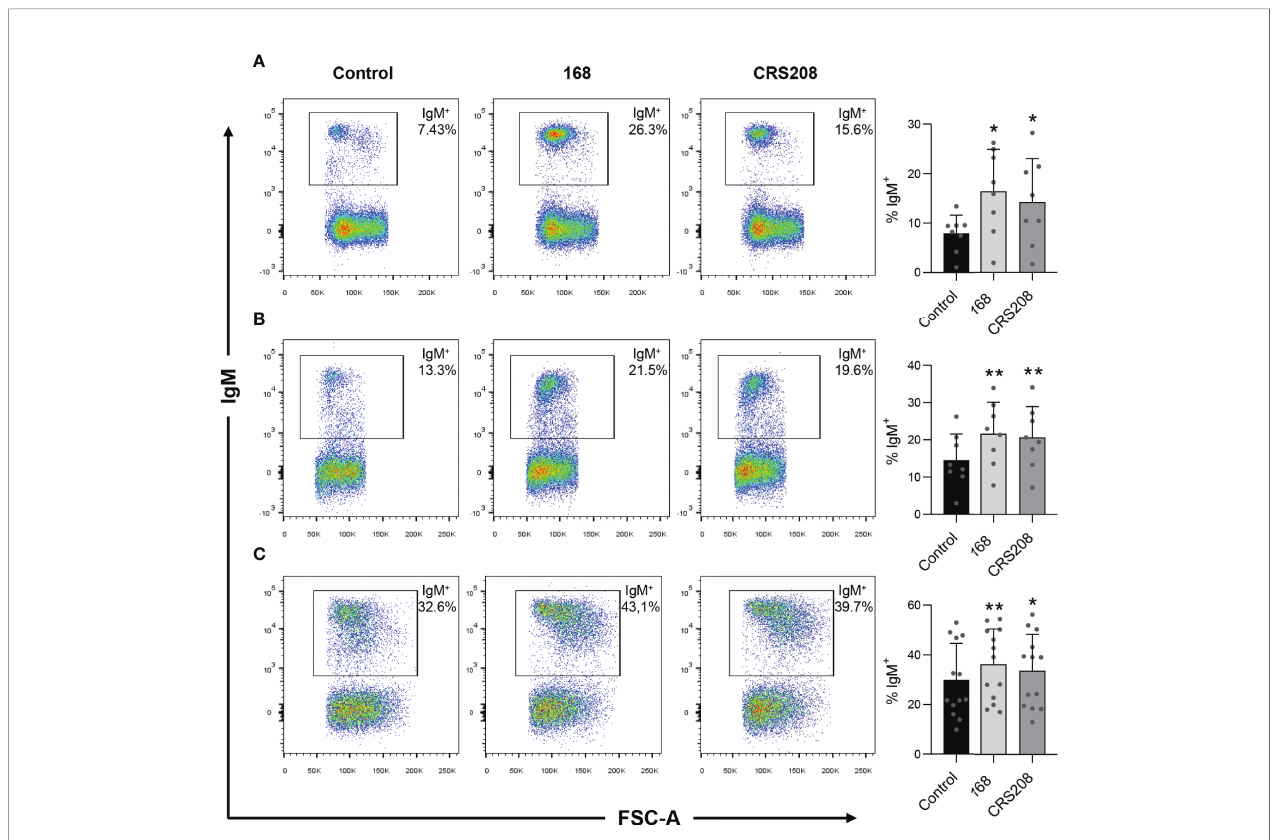
FIGURE 2 | Effect of B. subtilis 168 and CRS208 strains on the percentage of IgM + B cells. The percentage of IgM + B cells was measured via fl ow cytometry using a speci fi c anti-IgM in spleen (A) , kidney (B) and peritoneal (C) leukocyte cultures treated with 1x10 7 cfu/ml B. subtilis 168 or CRS208 strains for 48 h. Controls not treated with bacteria were also included. Representative dot plots are included along with graphs showing the percentage of live IgM + B cells in the lymphocyte gate (mean + SD; n=8). Statistical analyses were performed using a paired two-tailed Student ’ s t -test, after checking the normality using the Shapiro-Wilk test. Asterisks denote signi fi cant differences in stimulated cultures compared to control cultures, where * p ≤ 0.05 and ** p ≤